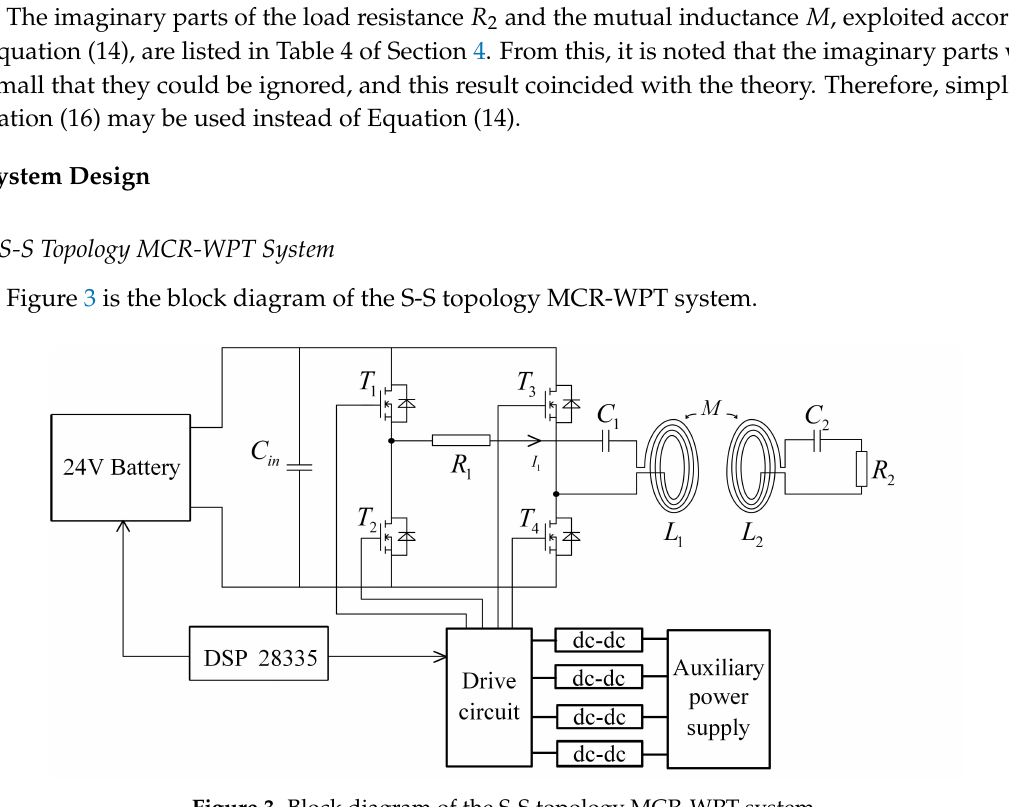
Figure 3. Block diagram of the S-S topology MCR-WPT